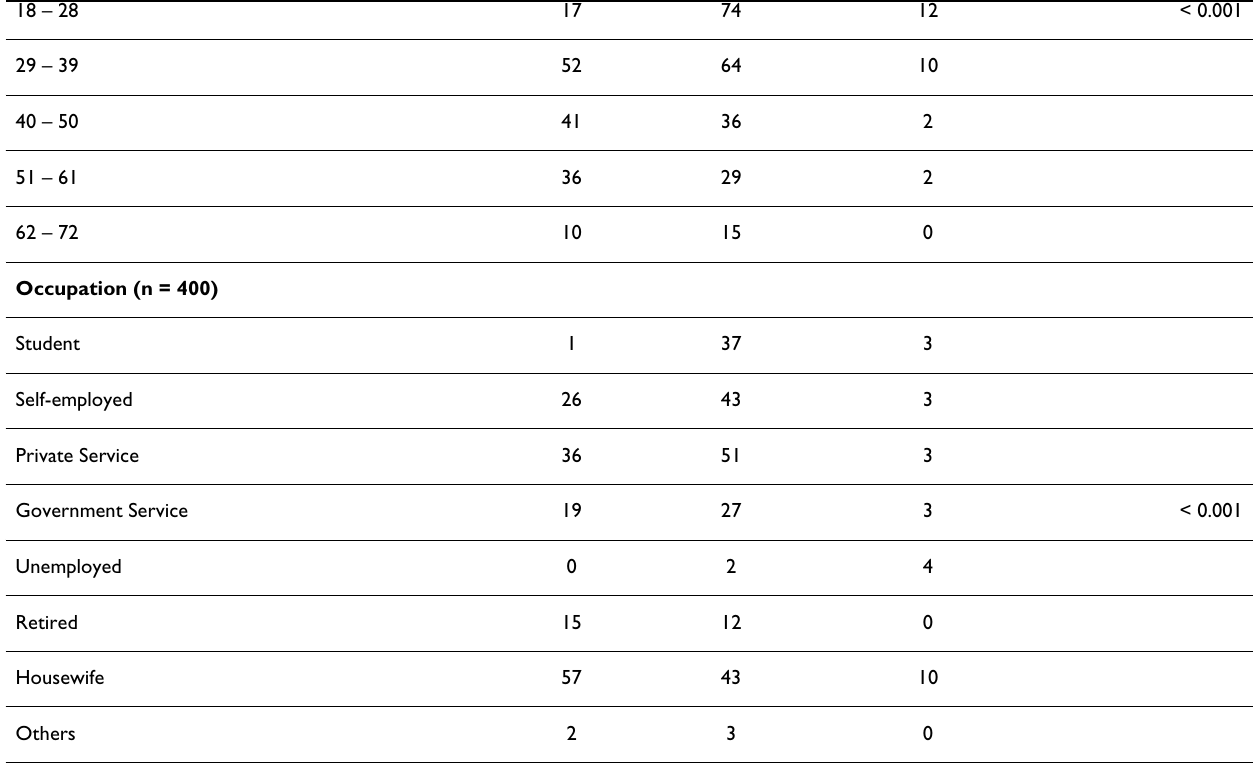
Table 4: Associations of belief that gemstones have an impact on health